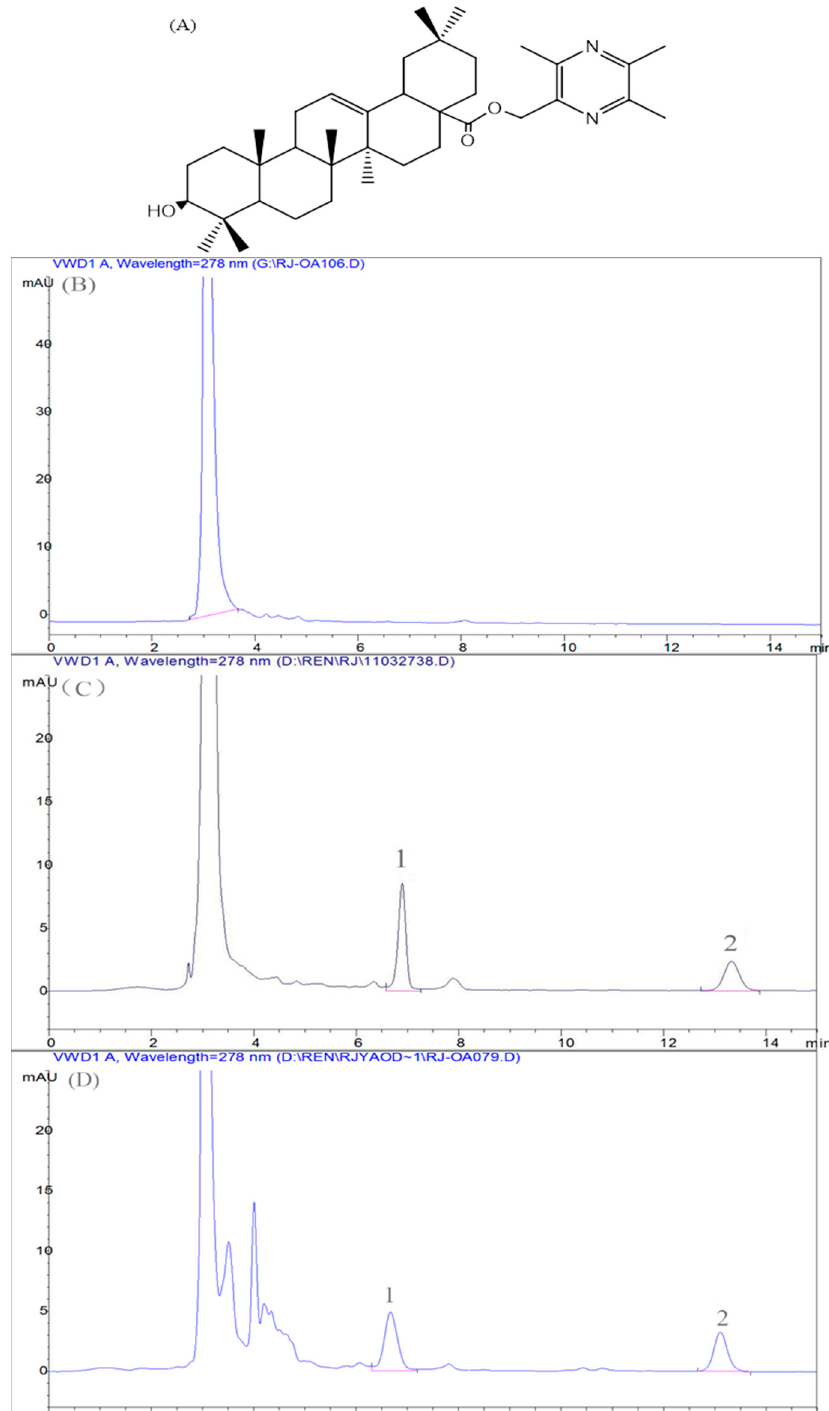
Figure 4. Representative high performance liquid chromatography (HPLC) chromatograms of the analytes detected at 278 nm. ( A ) Structures of internal standard (IS); ( B ) blank rat plasma; ( C ) blank rat plasma spiked with Oxy-Di-OA and IS; and ( D ) blank rat plasma sample collected at 12 h after administration of Oxy-Di-OA (500 mg/kg) added with IS; 1 Oxy-Di-OA; 2 IS. Calibration Curve and Linearity